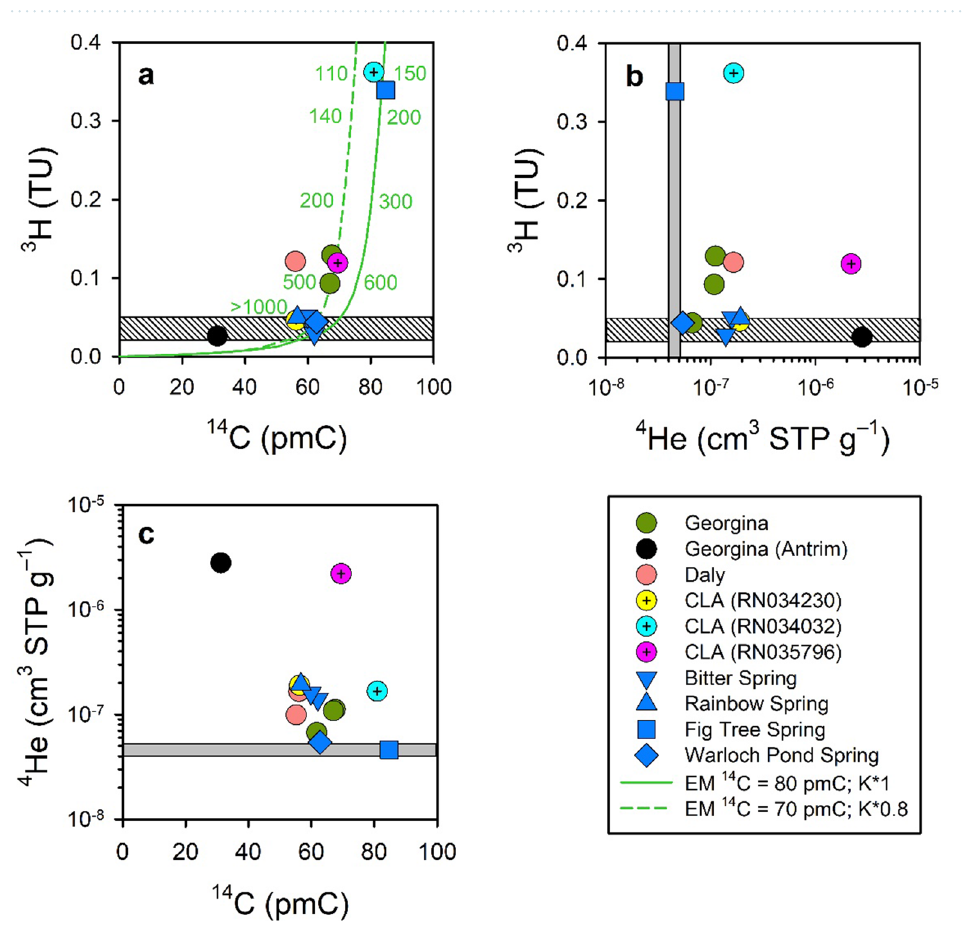
Figure 5. Trends in age-dating tracers in spring and groundwater. (a) 14 C and 3 H, also showing the Exponential Model (EM) for two ‘dead’ C correction factors and two formulations of the Kaitoke (K) 3 H input function; (b) 4 He and 3 H; (c) 14 C and 4 He. The vertical grey boxes represent the range in 4 He concentration expected for a CLA groundwater sample that would be at equilibrium with the atmosphere (i.e. that has no radiogenic 4 He). The horizontal stripped boxes represent the analytical detection limit for 3